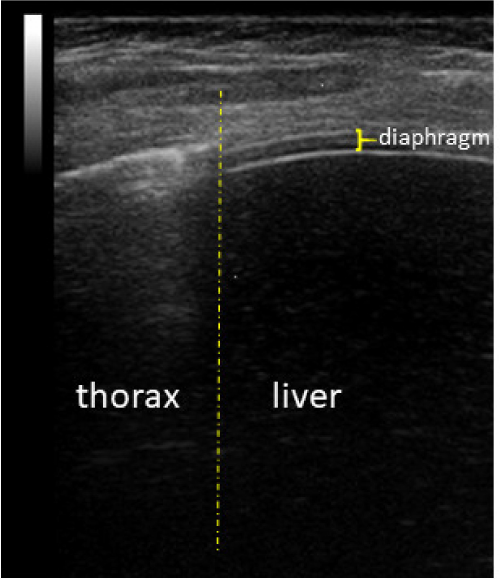
Figure 1. Ultrasound appearance of the diaphragm on the anterior axillar line. The measurements included diaphragm thickness at end-expiration (TEE) and at end-inspiration (TEI). During M-mode imaging, the normally functioning diaphragm was represented as an echogenic line that moves freely during inspiration and